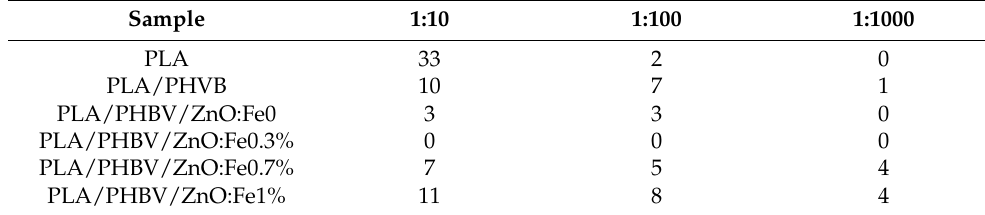
Table 5. Cell number (CFU) at different successive dilution for ZnO:Fe samples.